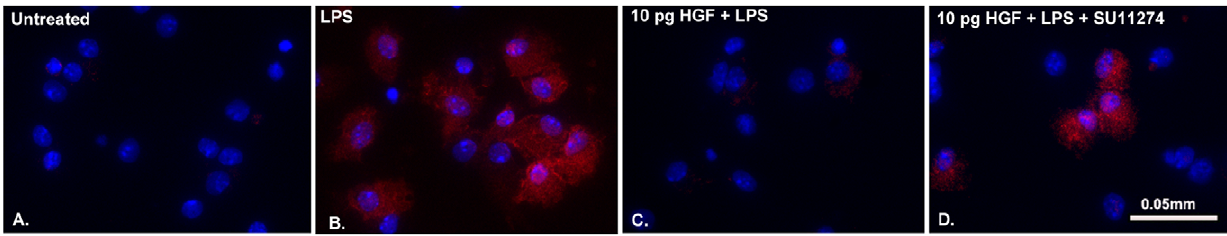
Figure 6. HGF prevents the nuclear translocation of phosphorylated p65. BMM were (A) untreated (B) stimulated with LPS (1 m g/ml) (C) treated with 10 pg HGF and stimulated with LPS (1 m g/ml) or (D) treated with the MET kinase inhibitor, SU11274, 10 pg HGF and stimulated with LPS (1 m g/ml). Cytospin preparations were then stained by immunoflourescence for phosphorylated p65 (Ser 276) and for nuclei with DAPI. The blue staining indicates nuclei, red staining indicates phosphorylated p65, and purple staining indicates colocalization of phospho-p65 within the nucleus.